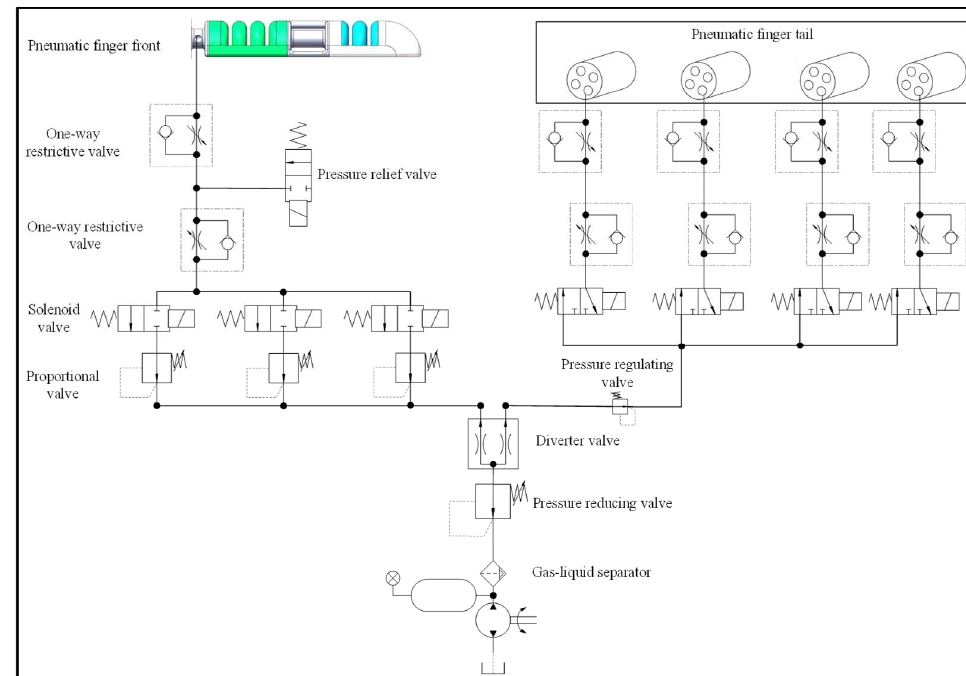
Figure 14. Pneumatic control schematic